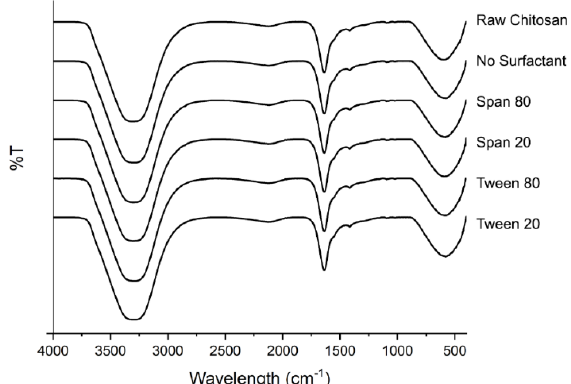
Figure 9. FTIR spectra of raw chitosan and hydrolyzed chitosan. The chitosan concentration, surfactant concentration, and reaction time were 1% ( w / v ), 7% ( w / w ), and 24 h, respectively.